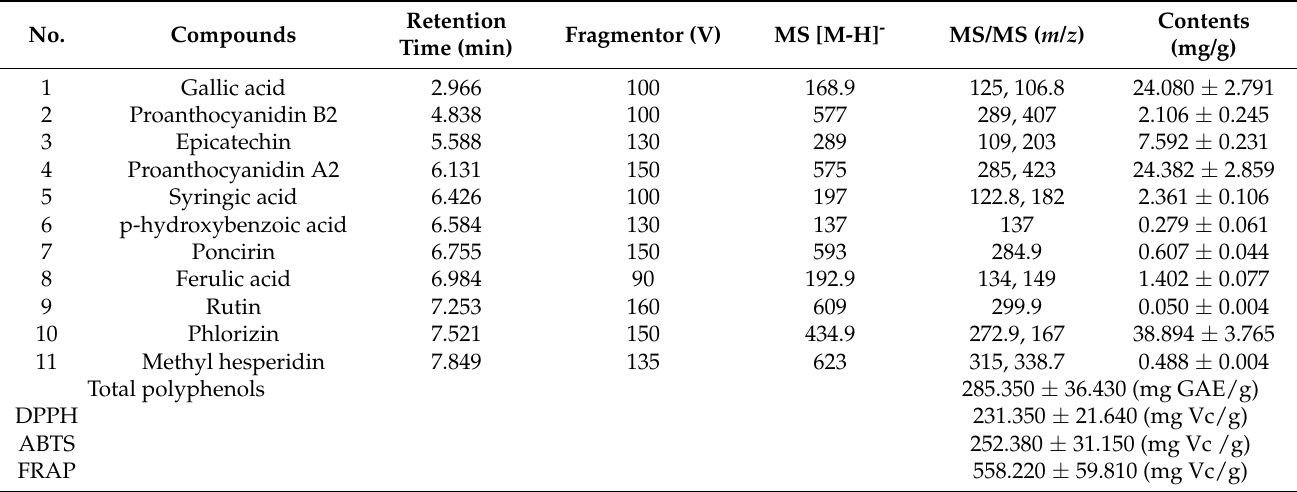
Figure 1. Representative chromatograms of the polyphenols in LPPE. 1—Gallic acid. 2—Proanthocyanidin B2. 3—Epicatechin. 4—Proanthocyanidin A2. 5—Syringic acid. 6—p-Hydroxybenzoic acid. 7—Poncirin. Table 1. Polyphenol composition, total polyphenols via Folin–Ciocalteu colorimetric method and antioxidant activities in vitro of LPPE. Values are expressed as the mean ± SEM.